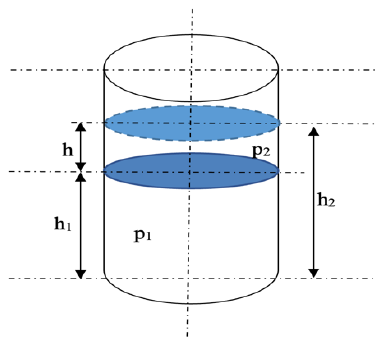
Figure 1. Measurement model of the change in liquid level in a vertical cylindrical tank.